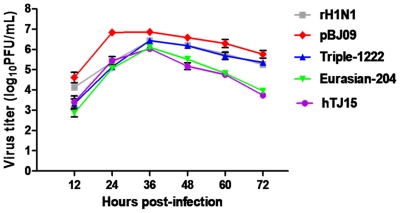
Viral growth kinetics in MDCK cells.MDCK cells were infected with virus at a MOI of 0.05, supernatants were harvested every 12 h, and samples were titrated by plaque assay in MDCK cells. Results represent the average of three independent experiments.